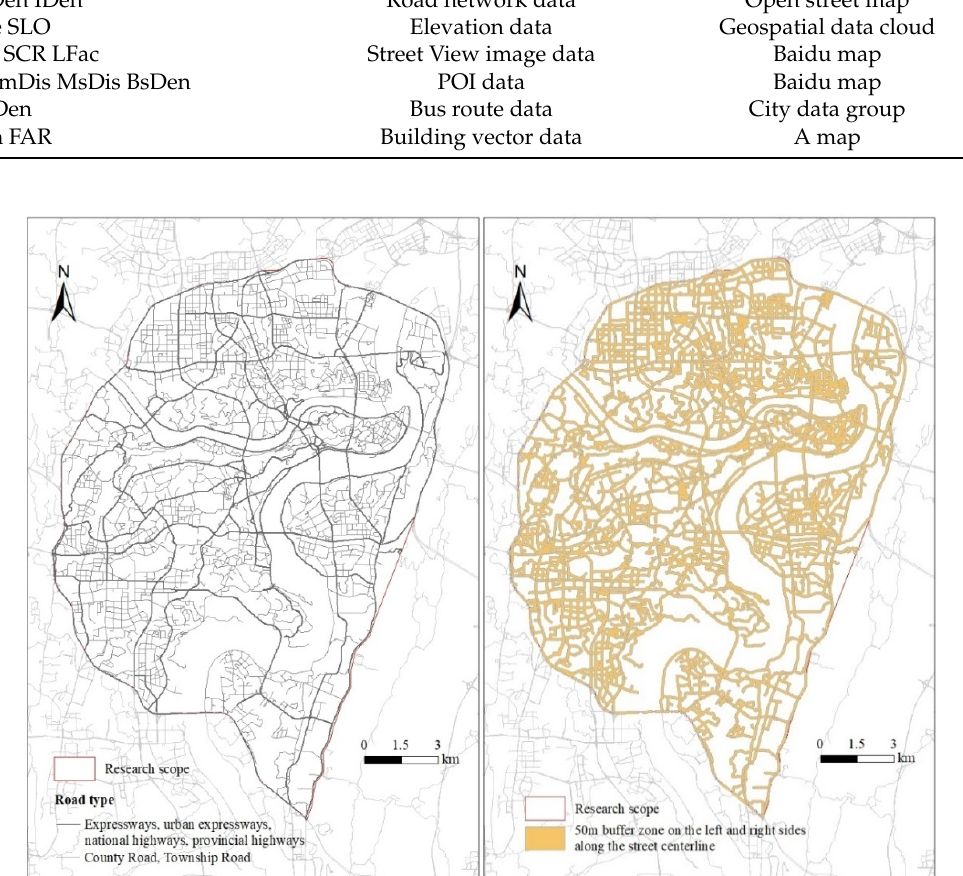
Figure 2. Road network and buffer zone after processing.